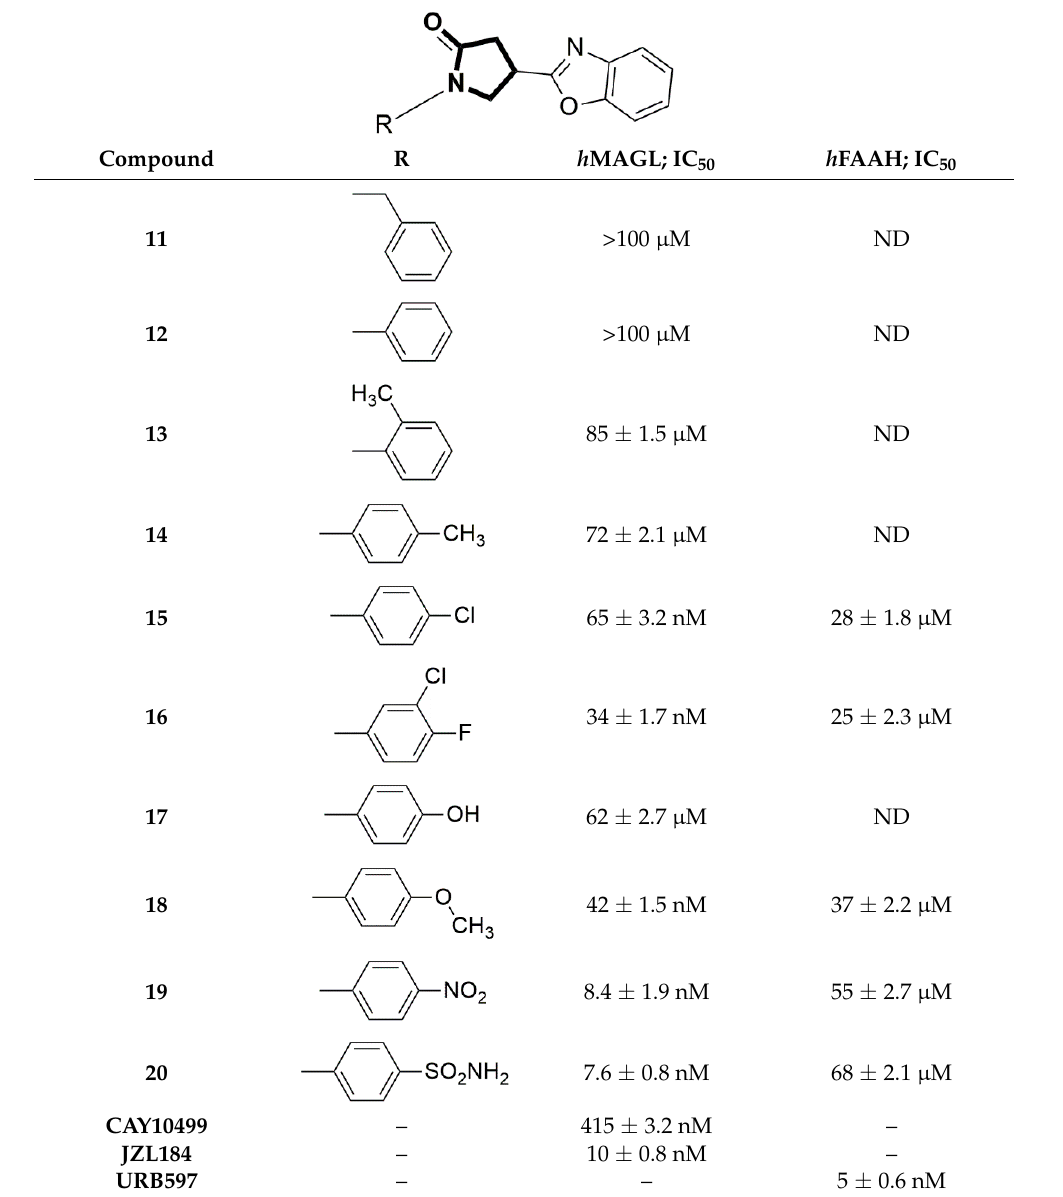
Table 1. In vitro h MAGL and h FAAH inhibition assay of the synthesized compounds ( 11–20 ).